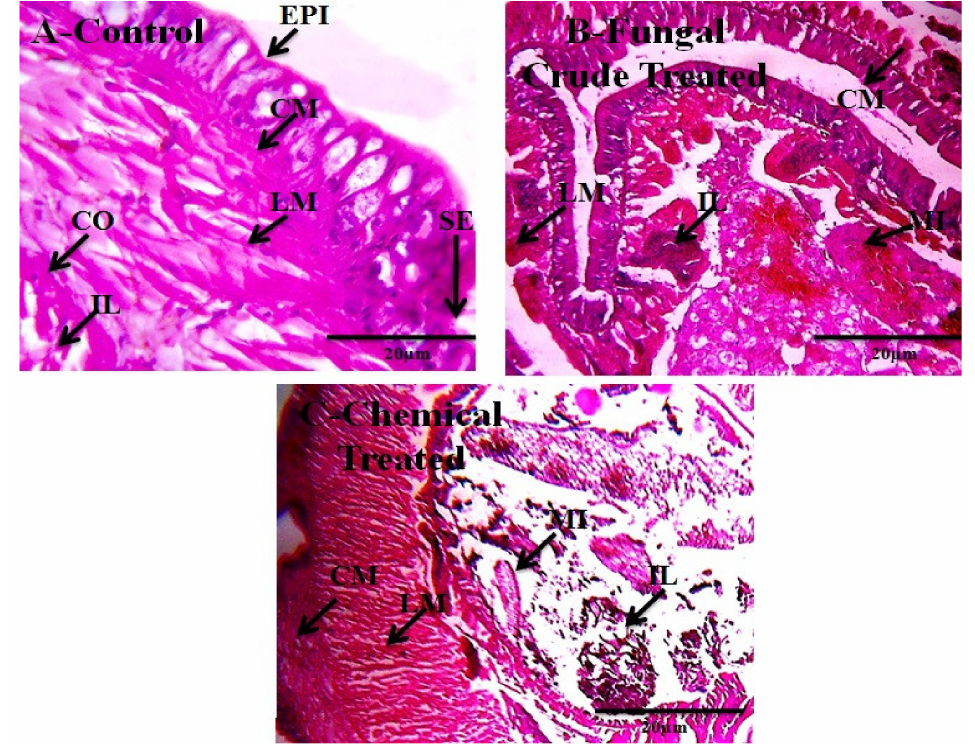
Figure 3. The M. anisopliae secondary metabolites (200 µ g/mL) were exposed E. eugeniae and after 30 days of treatment, the earthworm gut tissues were sectioned for histopathological evaluation and magnified at 40 × under a light microscope. ( A ) is control (without fungal crude extract treatment); ( B ) is fungal secondary metabolites treated; and ( C ) is Monocrotophos 200 ppm/kg treated. In the control and entomopathogenic fungi crude extract treatments, no changes were observed, but chemical pesticide treatment of several gut tissues morphology and shapes changed in the lumen tissues was entirely spoiled compared with control (EPI-epidermis, SE-setae, IL-intestinal lumen, LM-longitudinal muscle, CO-coelom, CM-circular muscle, MI-mitochondrion). Table 4. Thickness of the epidermis, intestinal epithelium, and body wall of earthworms after the 30 days treatment of M. anisopliae crude extract. The identical lower case letters do not differ significantly ( p >